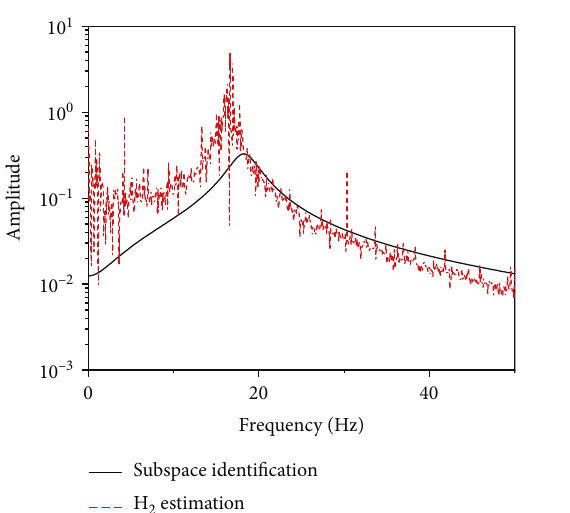
Figure 12: FRF of aileron rotational motion (dashed line: traditional H estimation; solid line: TNSI 2